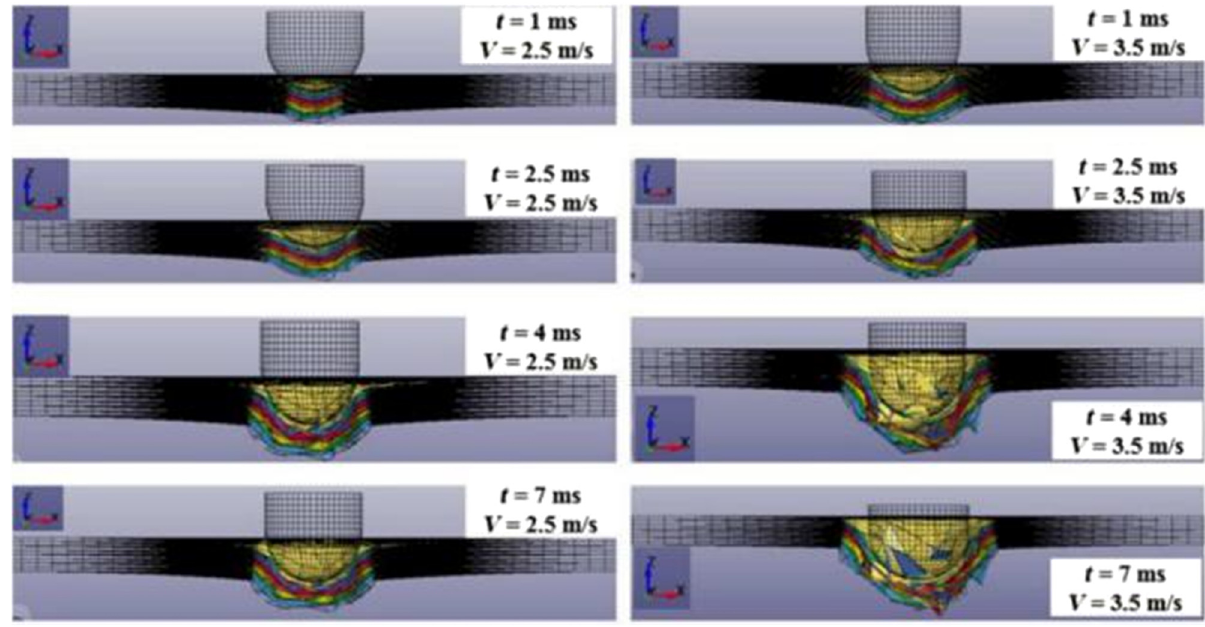
Figure 23: Permeation patterns at di ff erent times under the numerical analysis of LS - DYNA [ 108 ]